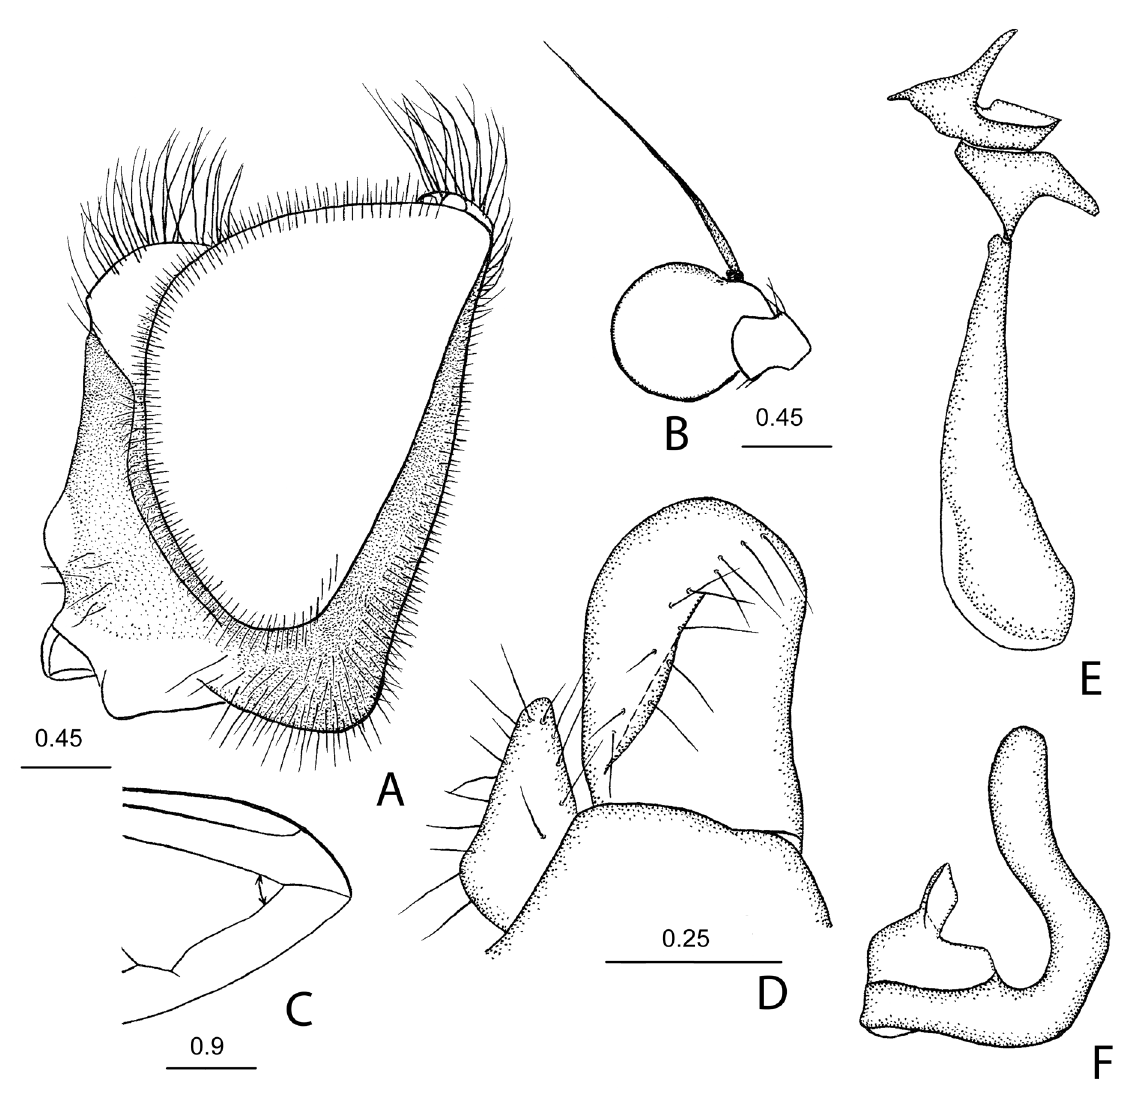
Fig. 39. Cheilosia ( Cheilosia ) maculata sp. nov., holotype, ♂ (ZSMC). A . Head, lateral view. B . Antenna, lateral view of pedicel and basoflagellomere. C . Tip of wing. D . Surstylus and gonocercus, lateral view. E . Aedeagus and aedeagal apodeme, lateral view. F . Superior lobe of hypandrium, lateral view. Scale bars indicated in